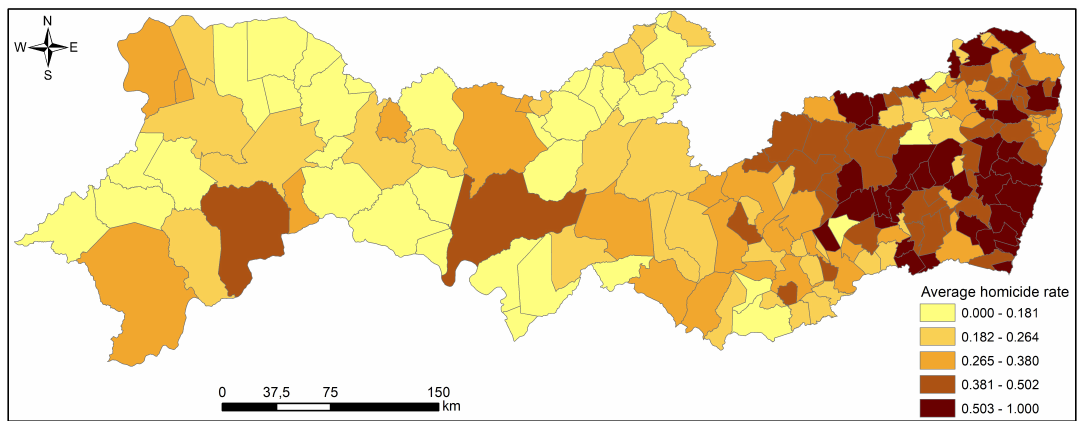
Figure 4. Homicide rates in the state of Pernambuco.